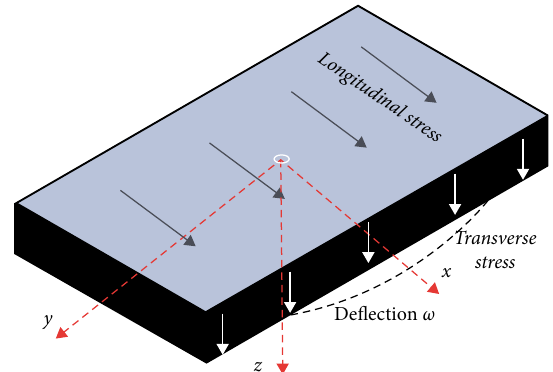
Figure 2: Temperature loading in the permafrost zone.